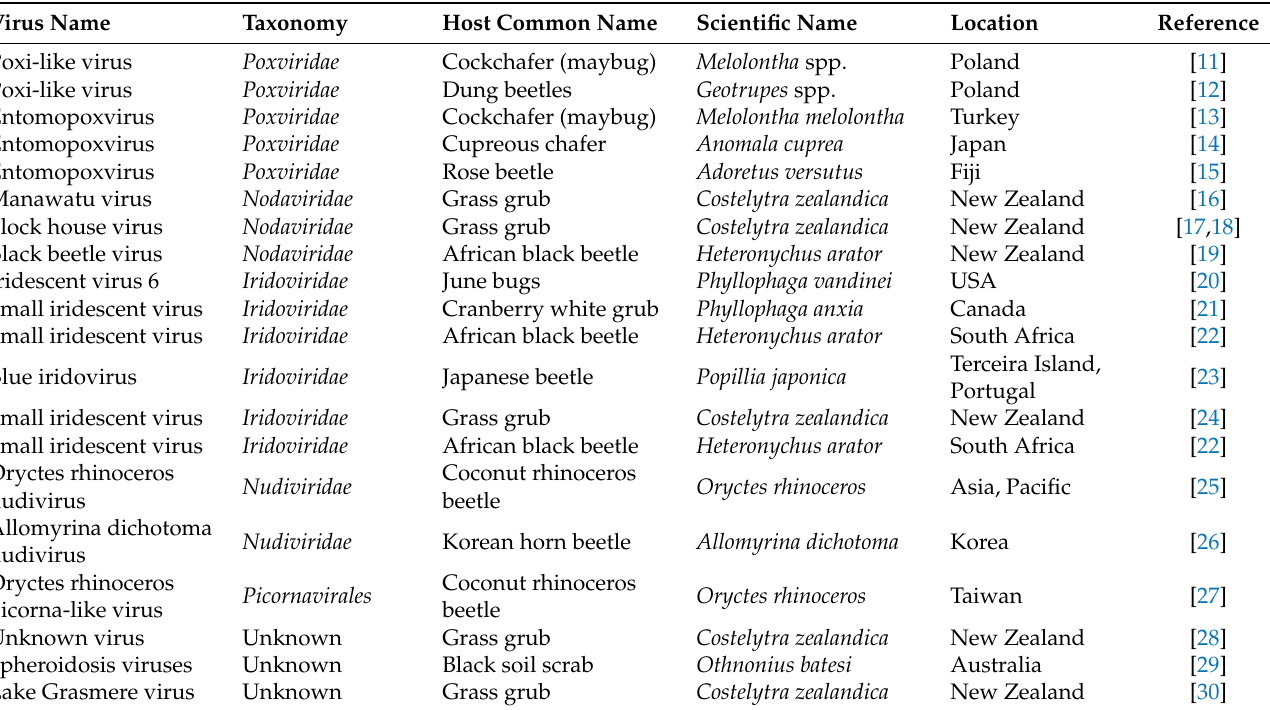
Table 1. Previously identified viruses from scarab